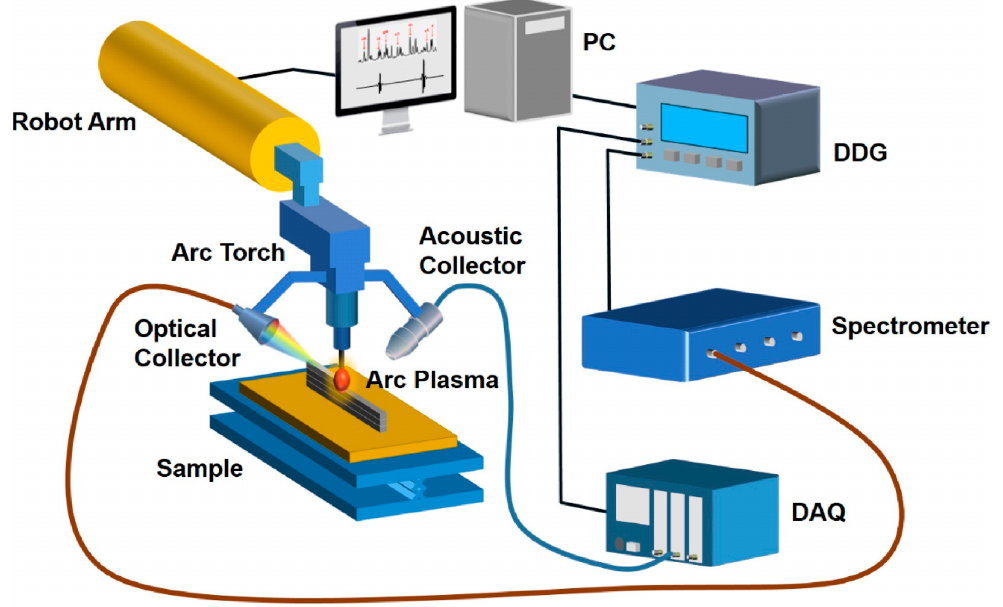
Figure 13. A schematic of a proposed laser opto-ultrasonic setup for online monitoring by Ma et al. [28].